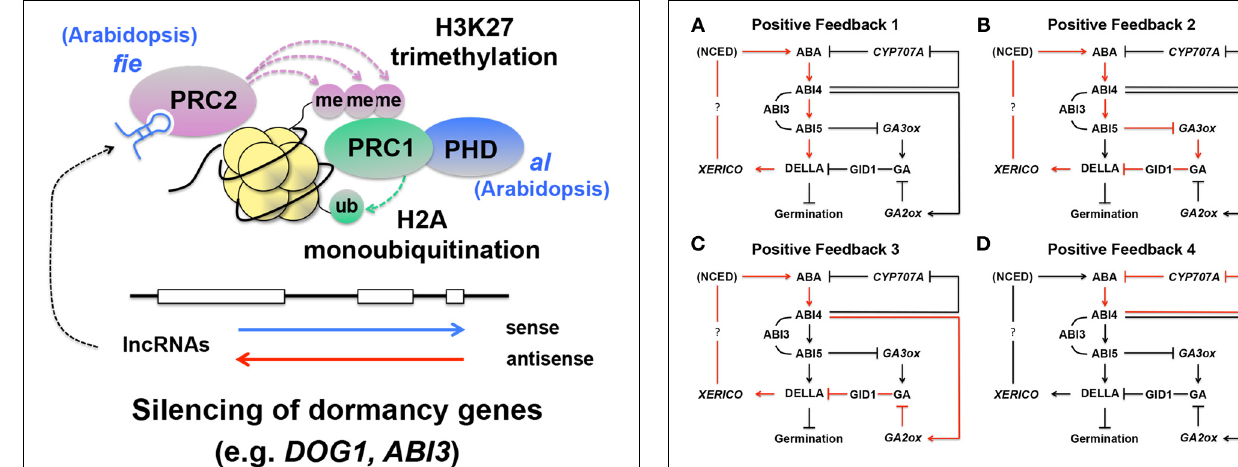
FIGURE 8 | Hypothetical integration of the known lncRNA-PRC pathway into the silencing mechanisms of seed dormancy genes. In this scheme, long non-coding RNAs (lncRNAs) (Swiezewski et al., 2009; Heo and Sung, 2011), interact with Polycomb Repressive Complex 2 (PRC2), which causes histone 3 lysine 27 trimethylation (H3K27me3) (Simon and Kingston, 2009; De Lucia and Dean, 2011). This histone modification recruits PRC1, which monoubiquitinates H2A (Simon and Kingston, 2009). While H2B monoubiquitination promotes transcription elongation (see Figure 2 ), H2A monoubiquitination is thought to be a repressive mark and silence genes (Simon and Kingston, 2009). A mutation in FERTILIZATION INDEPENDENT ENDOSPERM ( FIE ), an essential component of PRC2, causes enhanced dormancy (Bouyer et al., 2011), supporting the idea that PRC suppresses dormancy genes and promotes germination. A mutation in ALFIN1-like (AL), a Plant Homeo Domain (PHD) finger that interacts with PRC1, also promotes dormancy (Molitor et al., 2014). Evidence has not been obtained for the involvement of specific lncRNAs in suppression of dormancy genes through PRC.